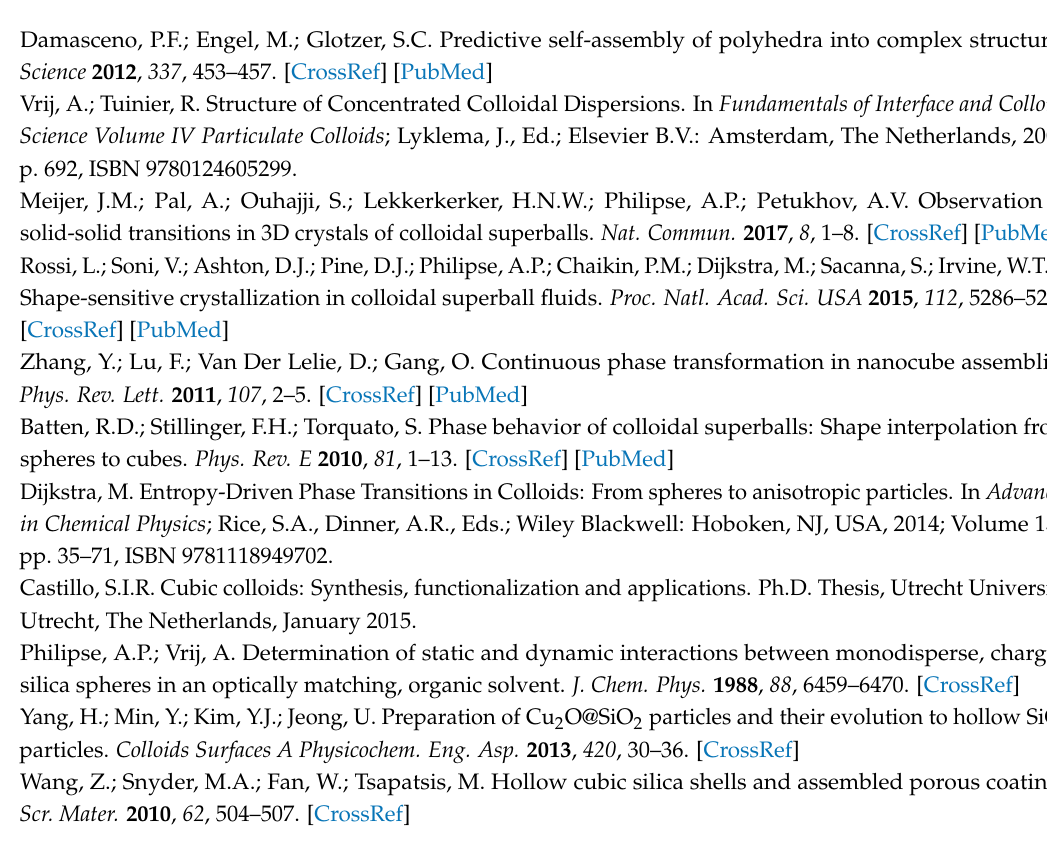
Figure S1: Illustration of the m -value determination: visualization of the method used to determine the aspect ratio of the cube. Figure S2: The thickness of the silica shell of Cu 2 O@SiO 2 particles plotted against the amount of TEOS added with respect to the dry weight of the particles